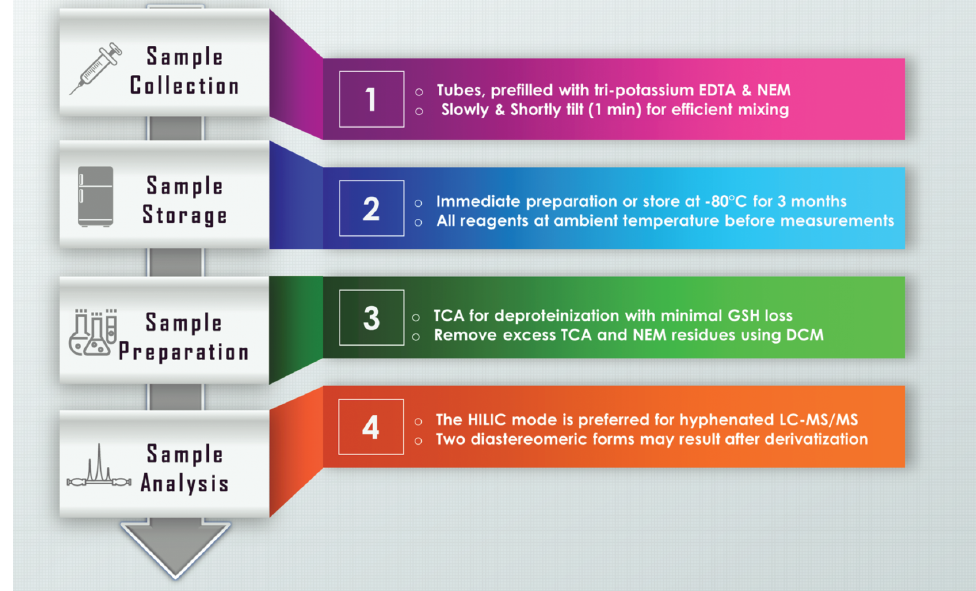
Figure 4: Procedures and precautions for GSH determination in